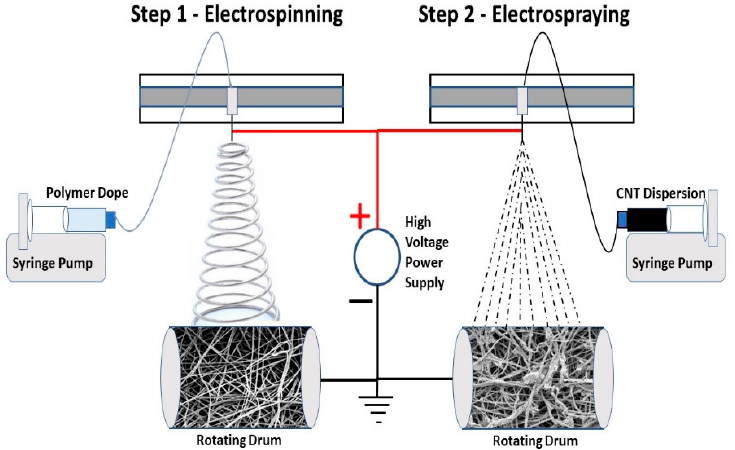
Figure 1. Schematic representation of nanocomposite membrane fabrication via electrospinning of PVDF-Co-HFP and electrospraying of CNT.